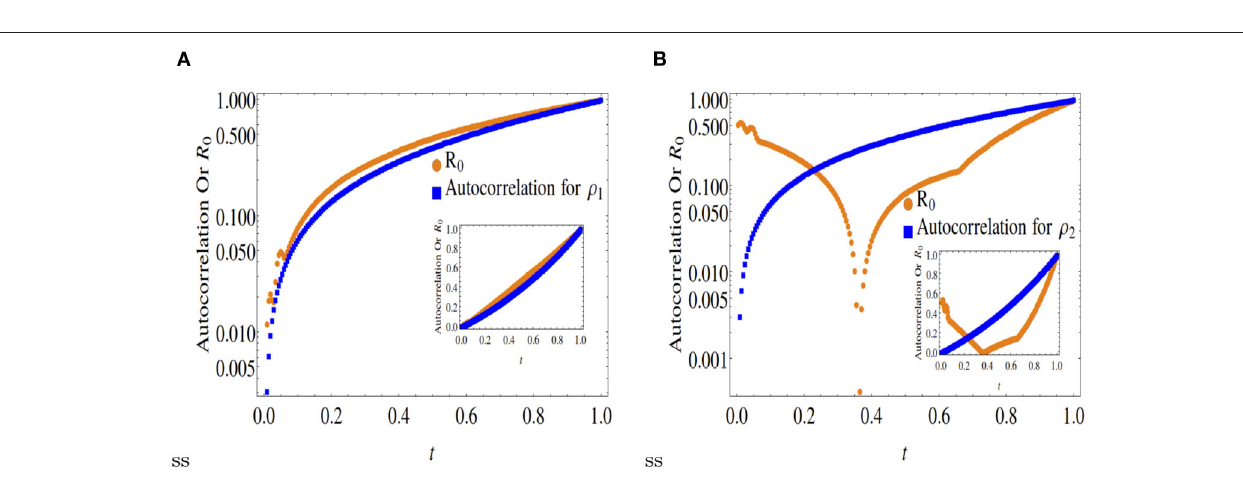
FIGURE 4 | Comparison of normalized autocorrelation and R 0 at x = 0.6. Outset is in log scale and inset is in original scale. The dynamics at x = 0.6 is almost similar to that of at x = 0.5, as shown in Figure 3 . (A) Autocorrelation and R 0 of ρ 1 at x = 0.6. (B) Autocorrelation and R 0 of ρ 2 at x =